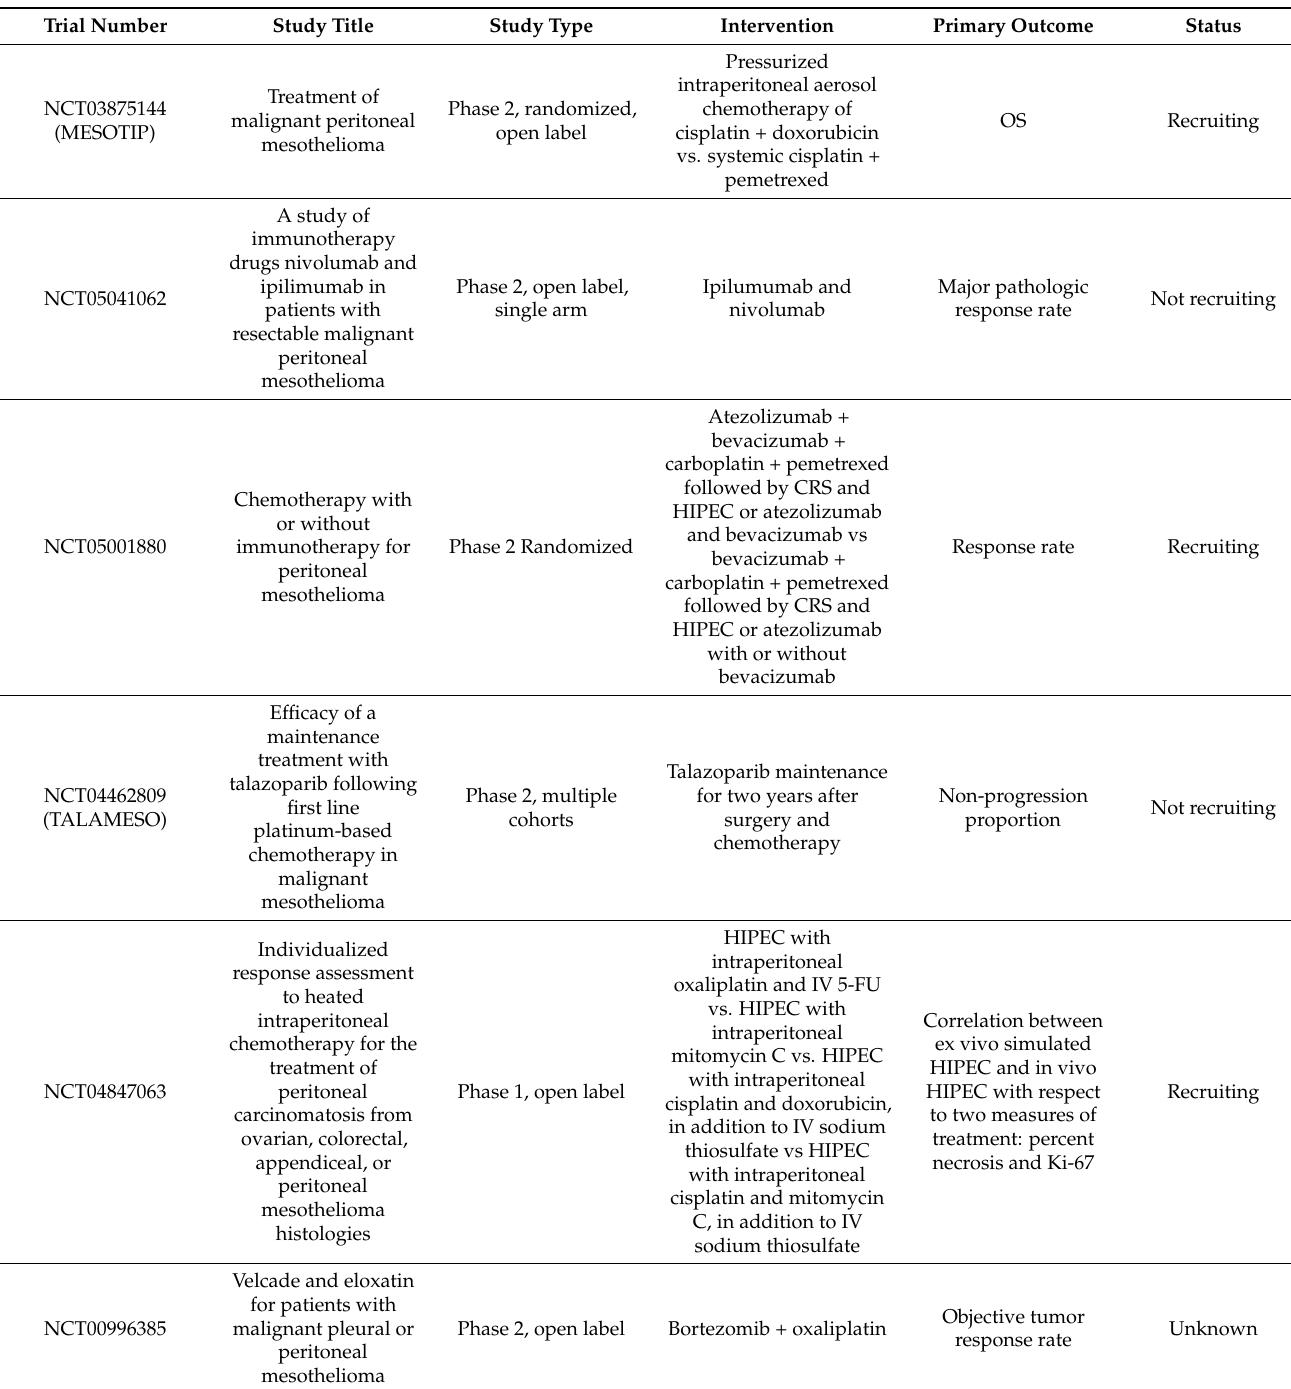
Table 7. Selected ongoing treatment trials in primary peritoneal mesothelioma. Source: Clinicaltri- als.gov, accessed 1 February